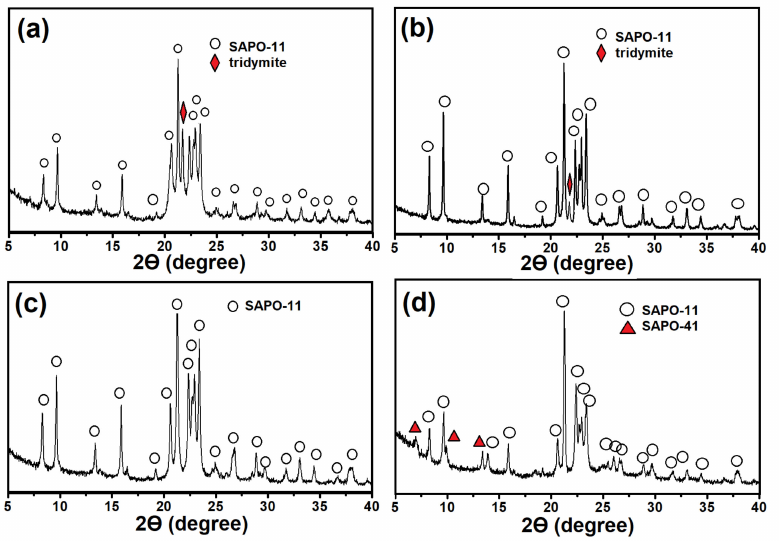
Figure 2. X-ray diffraction patterns of the products of crystallization of silicoaluminophosphate gels: ( a ) Sample SAPO-11-PB-1.0; ( b ) Sample-SAPO-11-PB-1.5; ( c ) Sample-SAPO-11-iAl-1.0; ( d ) Sample- SAPO-11-iAl-1.5.